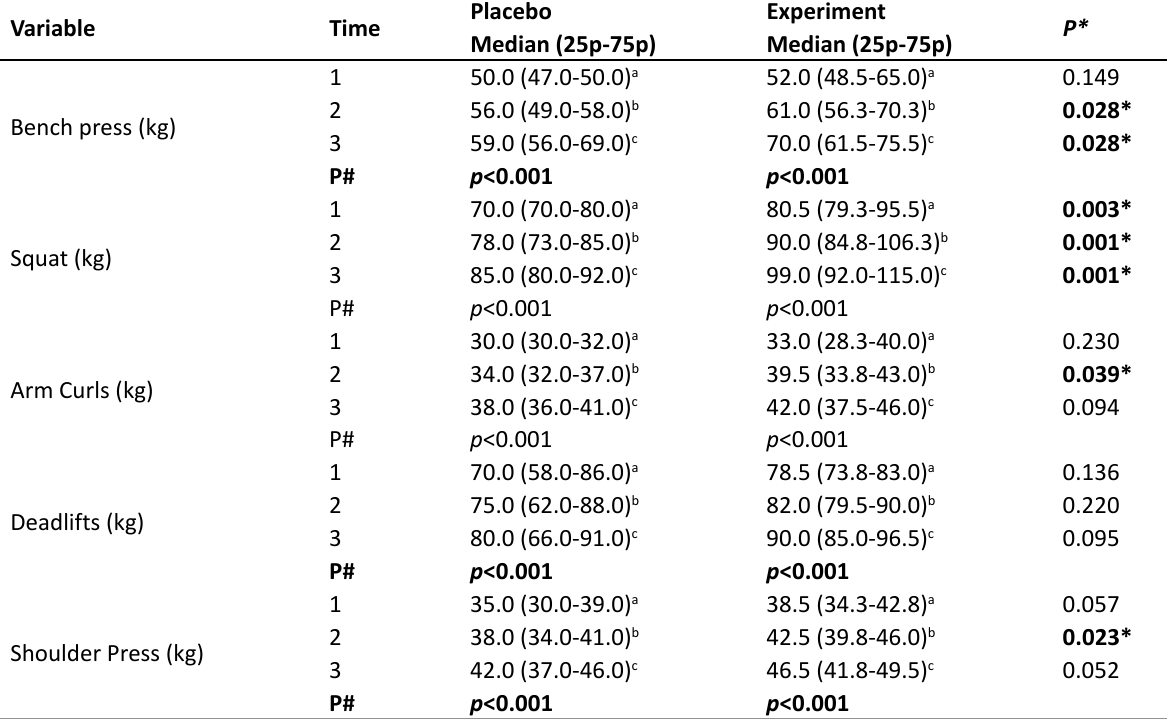
Table 2. Comparison of bench press, squat, arm curls, deadlifts and shoulder press movements of the groups Variable